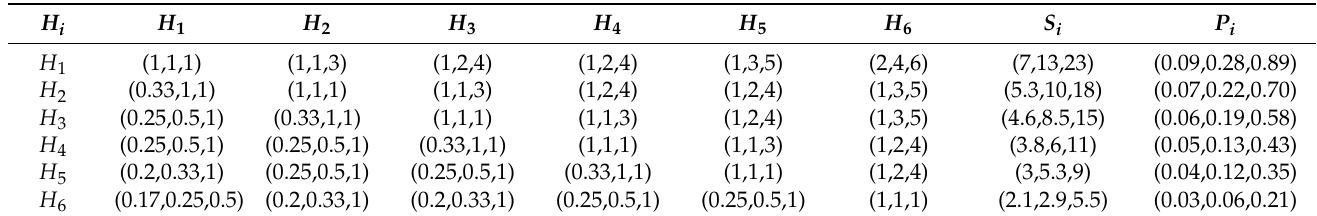
Table 2. Fuzzy judgment matrix and fuzzy synthetic extent of hazard indicators.